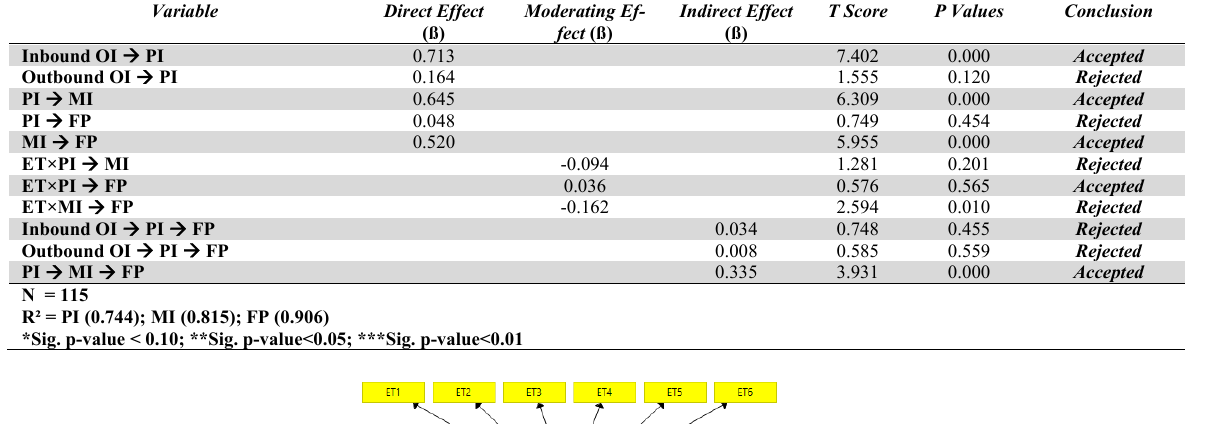
Statistical Effect and Hypotheses